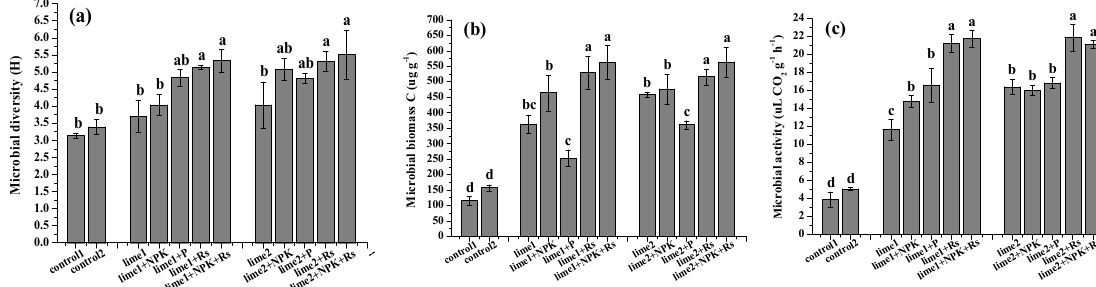
Figure 1. Soil microbial diversity, biomass C and activity in the mine soil with different amendments (means ± S.E., n = 4). The bars with different letters indicated significant differences at p < 0.05 according to LSD test. lime1 (25 t ha -1 ), lime2 (50 t ha -1 ), Rs (river sediment 30%, w:w); ( a ) Soil microbial diversity; ( b ): Soil microbial biomass C ( c ): Soil microbial activity